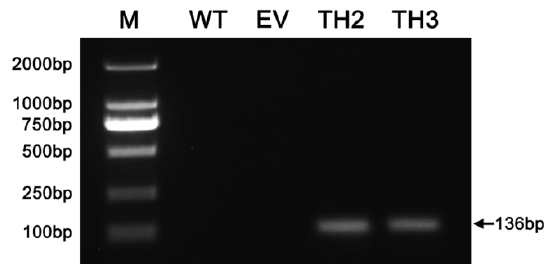
Figure 3. Transcription of CgHSP70 in transgenic plants and non-transgenic A. thaliana